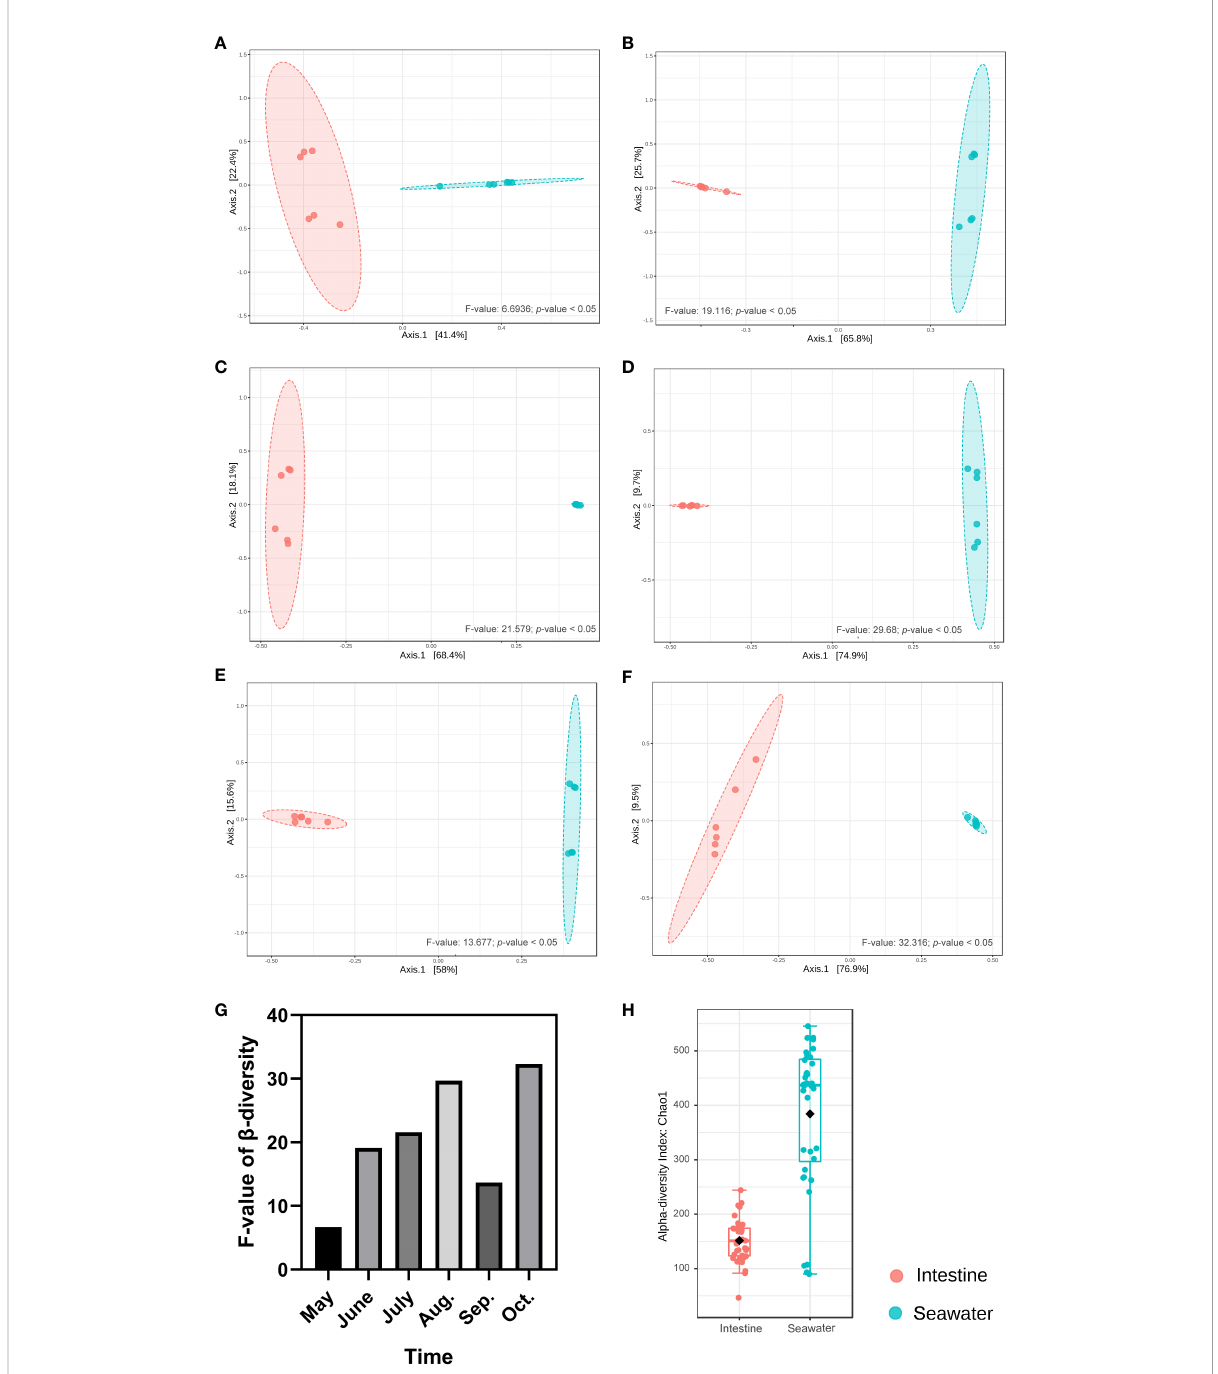
FIGURE 5 Beta and alpha diversity analyses between intestinal and seawater bacterial communities. (A-F) Beta diversity analyses of samples from May to October; (G) The F-values of beta diversity analyses in different months; (H) Alpha diversity analysis between intestinal and seawater bacterial